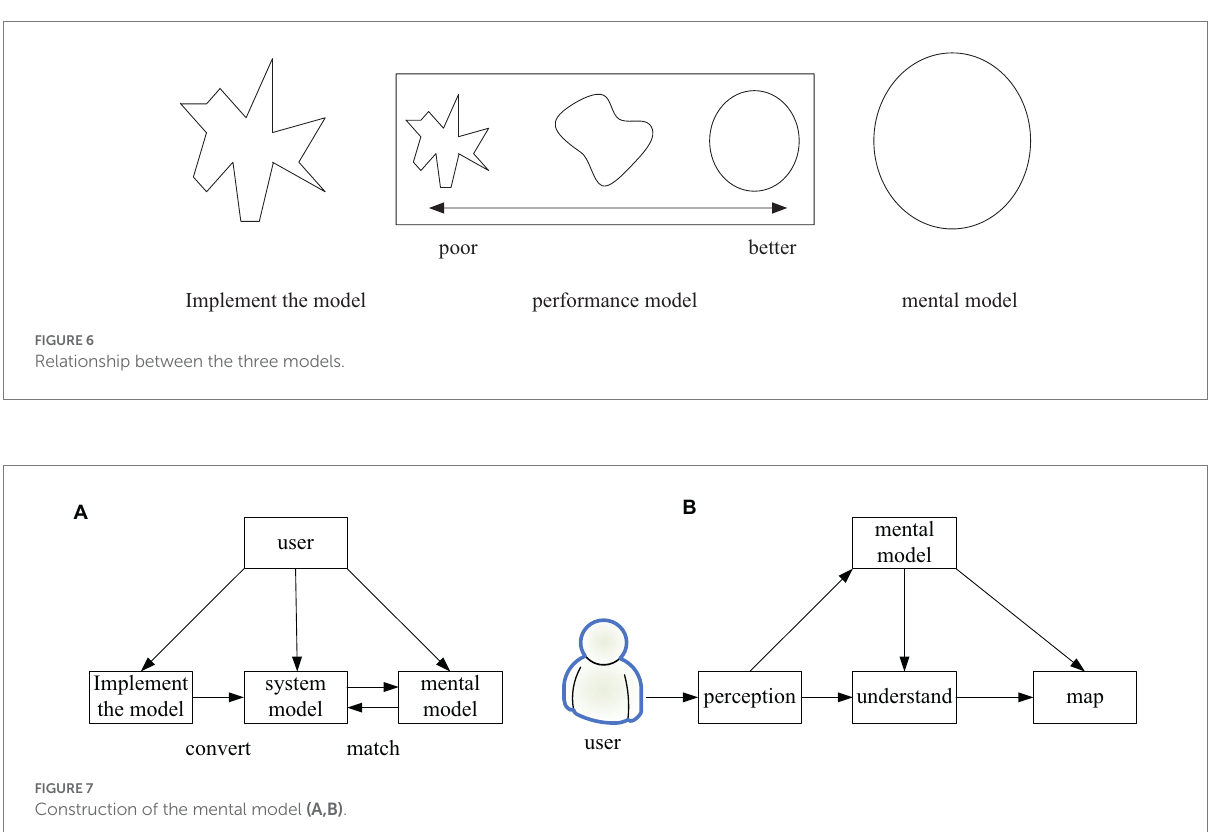
FIGURE 7 Construction of the mental model (A,B)